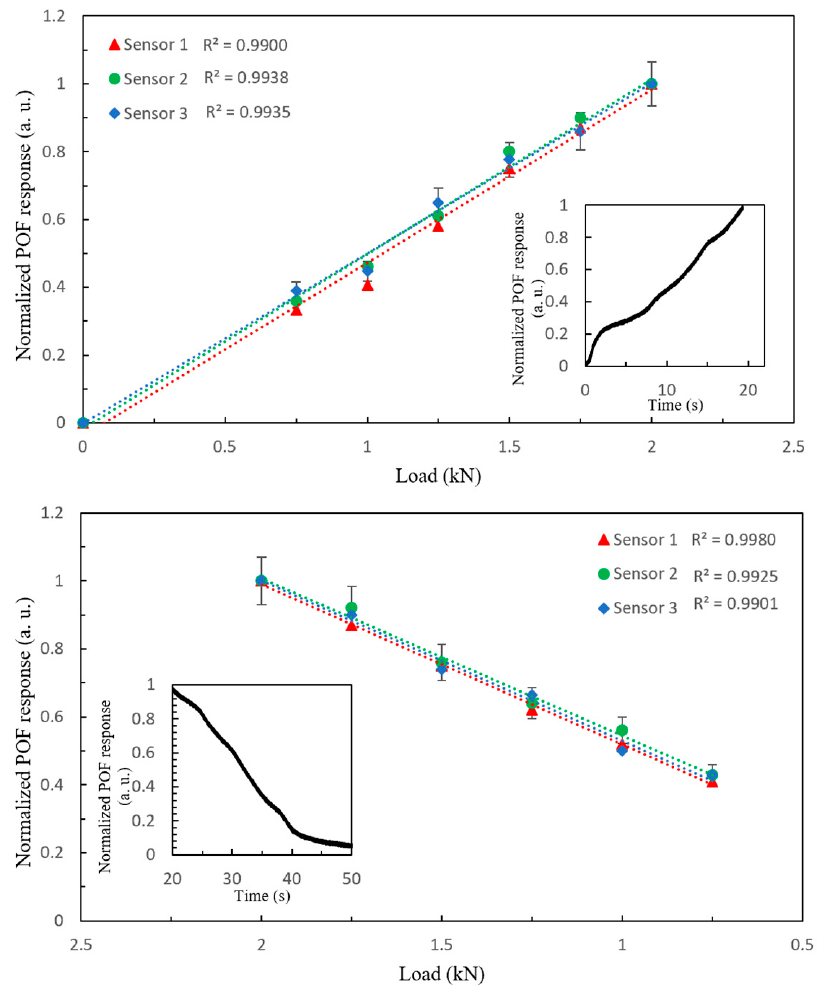
Figure 9. Applied load and normalized POF sensor response for a load and unload ramp of 2 kN with 10 N step for three different sensors.